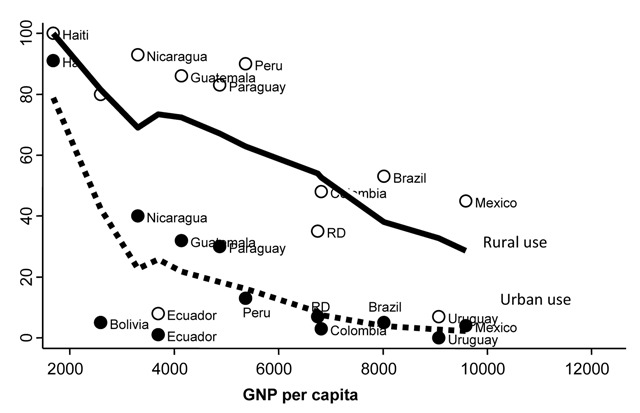
Dependence of biomass fuel use (vertical axis) on socioeconomic status (gross national income, horizontal axis) with a higher use in rural areas (empty circles) than in urban areas (filled circles). Solid fuel use has decreased in the last years but relationship remains similar. RD: Dominican Republic.